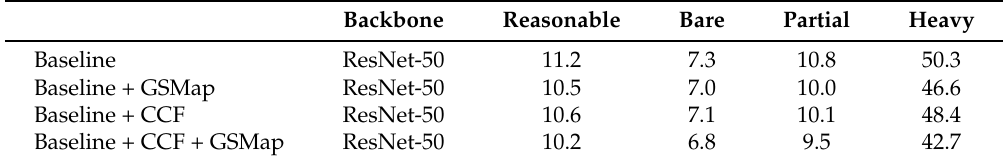
Table 4. Ablation study of global smooth map on the Citypersons dataset.